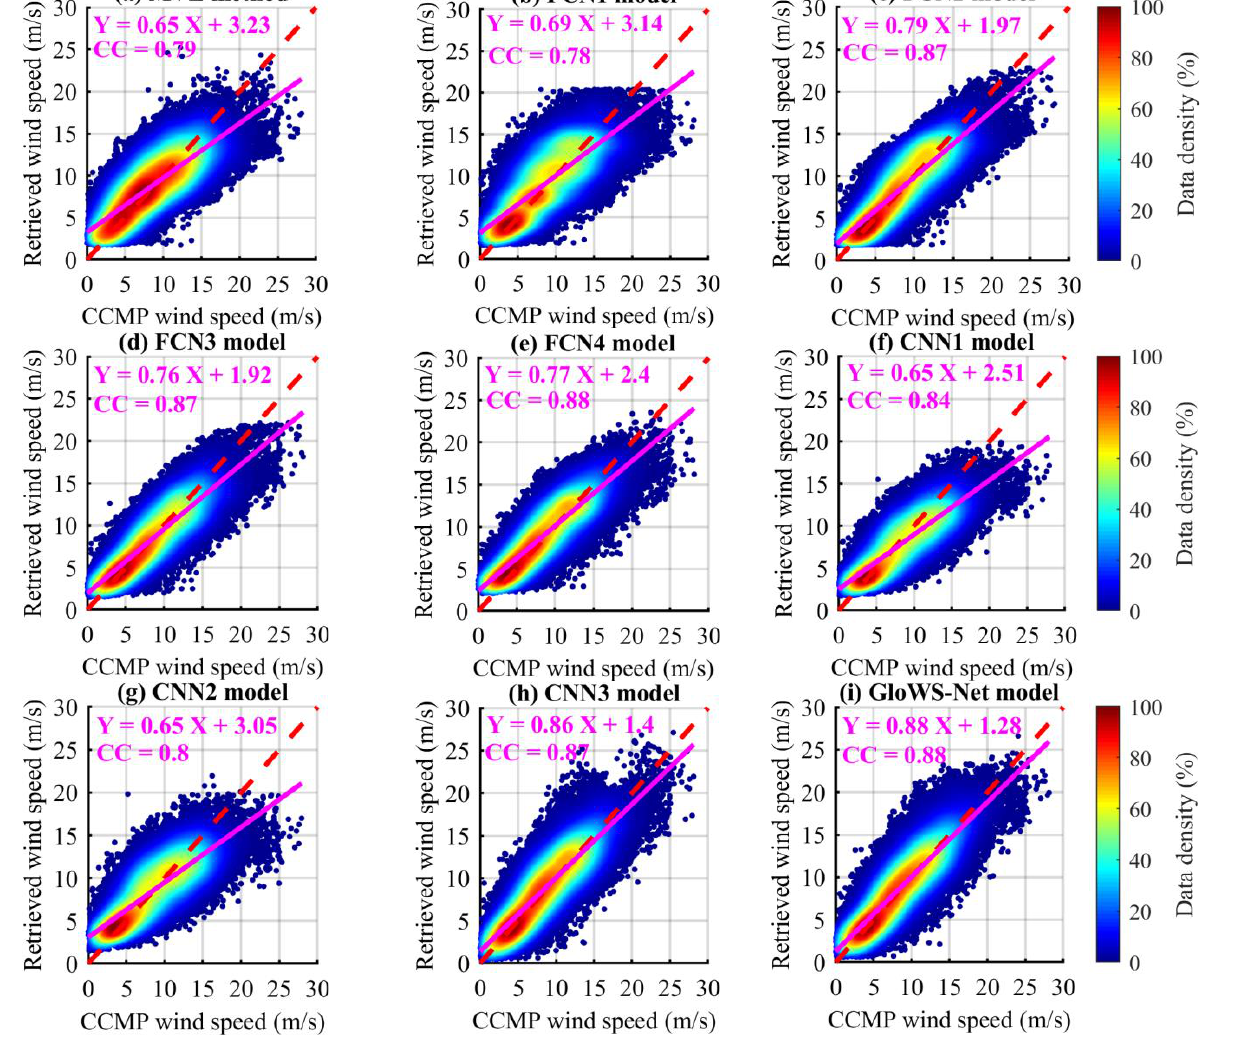
Figure 10. Scatter density plots of retrieved wind speed by different models and CCMP wind speed.